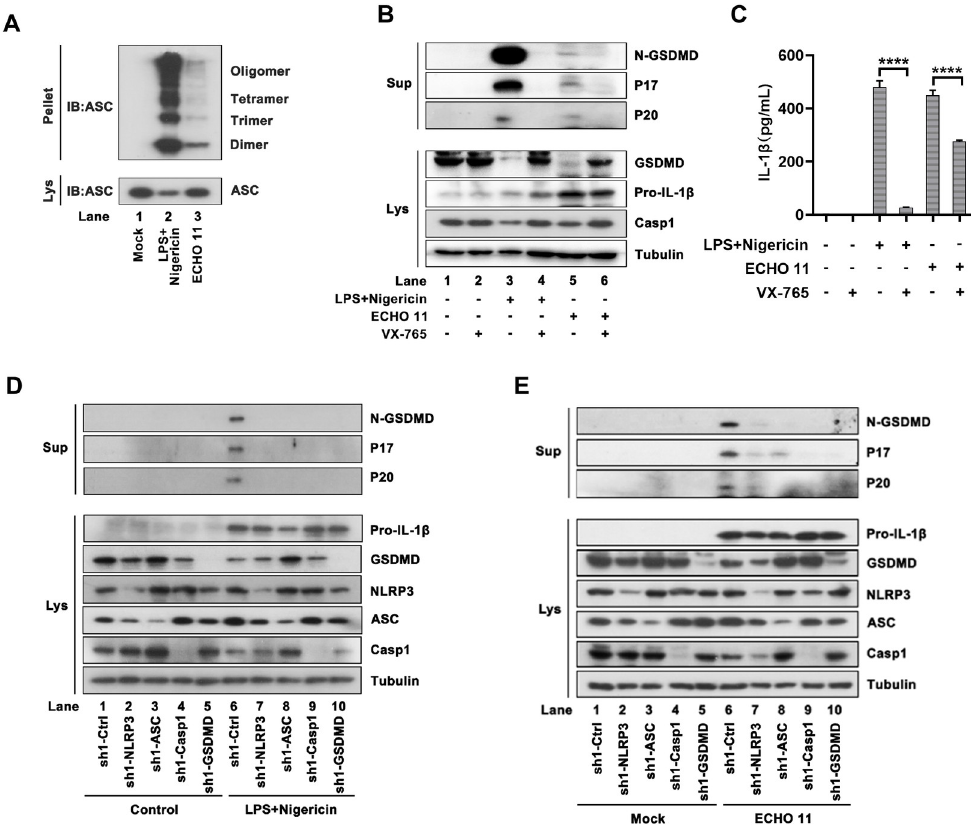
Fig 3. ECHO 11 infection induces pyroptosis through the activation of NLRP3-inflammasomes. ( A ) PMA- differentiated THP-1 macrophages were infected with ECHO 11 at MOI of 0.1, at 24 h.p.i., cells were lysed and the pellets were subjected into cross-link. The ASC oligomerization in the pellets and the total ASC in lysates as the input were examined by Western blotting. Cells treated with LPS/Nigericin were used as the positive control. ( B ) THP-1 cells were infected with ECHO 11 at an MOI of 0.5 for 24 h, and cells treated with CASP-1 inhibitor VX-765 (50 μ M) were used as the control. GSDMD-N, P17 and P20 in the supernatants, and GSDMD, pro-IL-1 β and CASP-1 in the lysates were examined by Western blotting. ( C ) Mature IL-1 β levels in supernatants were determined by ELISA. Data represent means and SD from three repeated experiments. ���� , P < 0.0001, as measured by two-way ANOVA. ( D-E ) THP-1 cells stably expressing control shRNA (Ctrl) or specific shRNA targeting NLRP3, ASC, CASP-1 and GSDMD were treated with LPS /Nigericin (D) or infected with ECHO 11 at an MOI of 0.5 for 24 h (E). GSDMD-N, P17 and P20 in the supernatants, and GSDMD, pro-IL-1 β and CASP-1 in the lysates were examined by Western